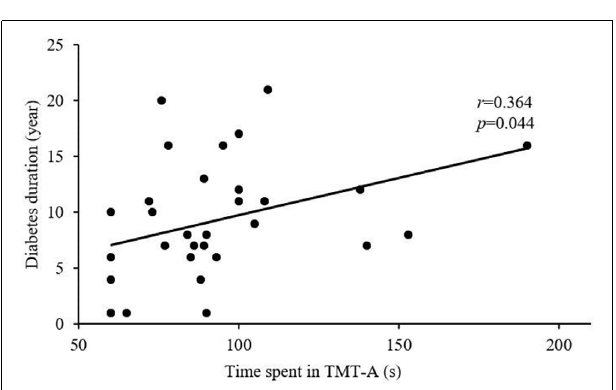
FIGURE 4 | Correlation between TMT-A score and T2DM duration ( r = 0.364, P =